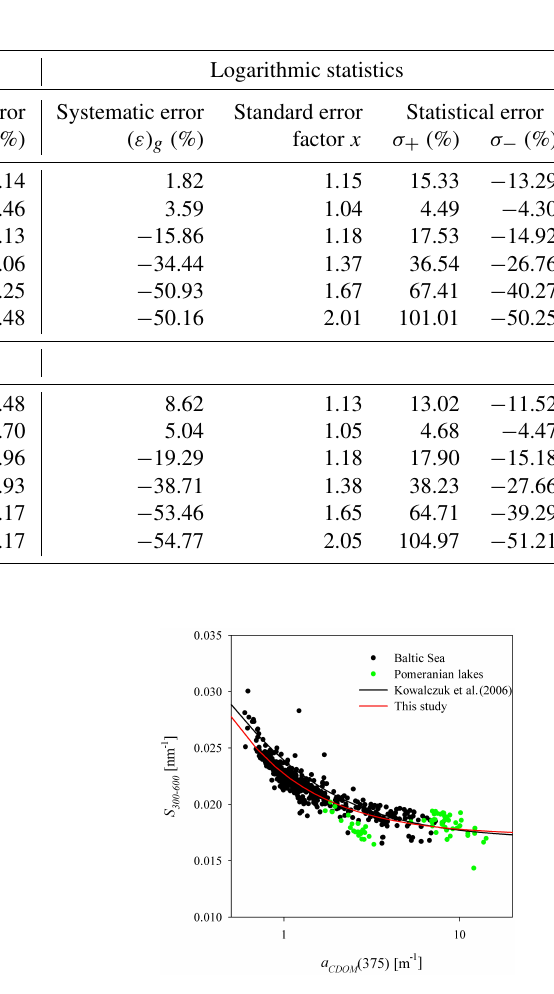
Figure 8. The relationship between the spectral slope coefficient S and a CDOM (375) in the Baltic (black dots) and lakes (green dots). The black line indicates the model of Kowalczuk et al. (2006) and the red one our new approximation (Eq.